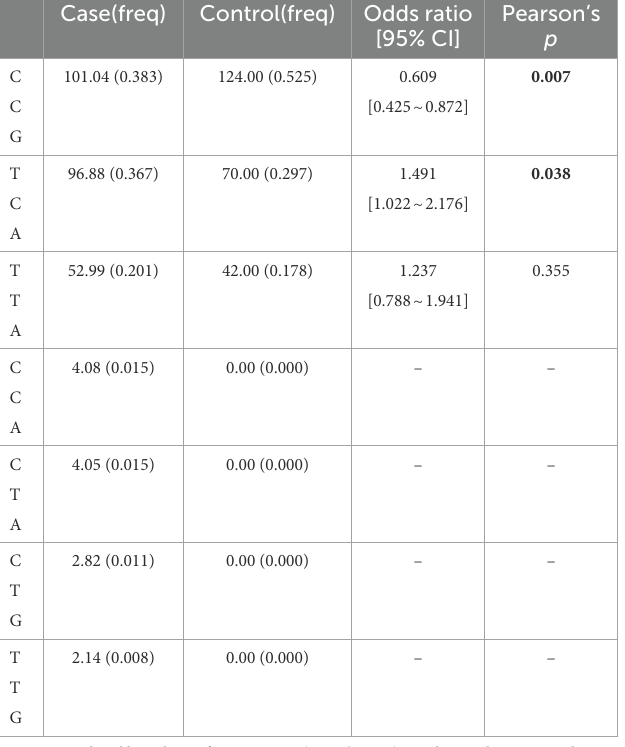
TABLE 4 Haplotype analysis of PRKAA1 rs13361707, rs3792822, and rs10074991 with the risk of PHN.